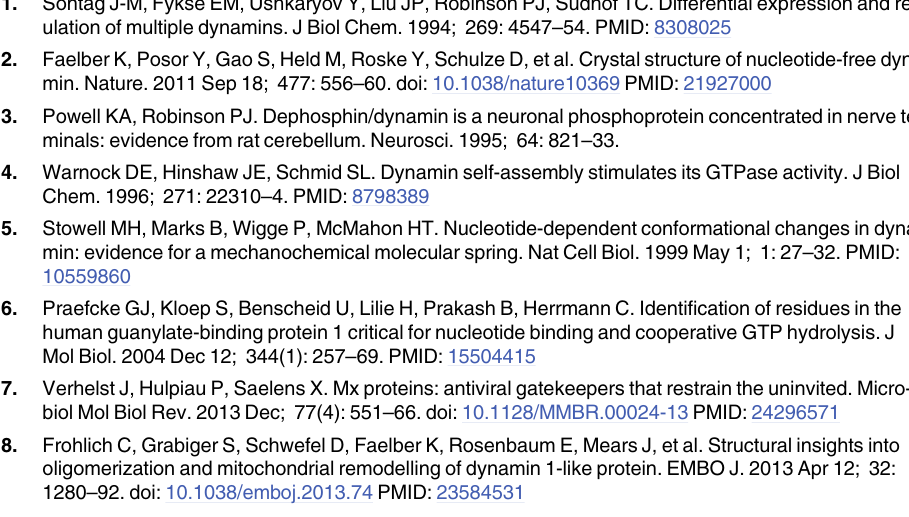
S3 Fig. Amino acid sequence of the dynamin I middle domain α 2 helix splice variants ‘ a ’ and ‘ b ’ using CLUSTALW omega. Middle domain splicing of dynamin I (dynI) arises from two alternate exons coding for the residues 400 – 445 of the middle domain. The differences in residues between sequences are highlighted in red. (A) Human dynamin I ‘ a ’ vs. ‘ b ’ . Species comparison of dynamin I middle domains (B) ‘ a ’ and (C) ‘ b ’ . Abbreviations : bdynI,